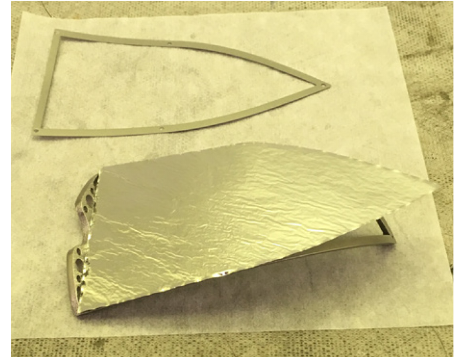
Fig. 3. Placement of foil on frame prior to addition of